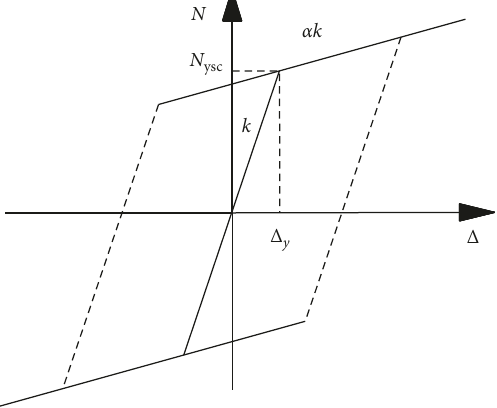
Figure 10: The MPE for BRB simulation.